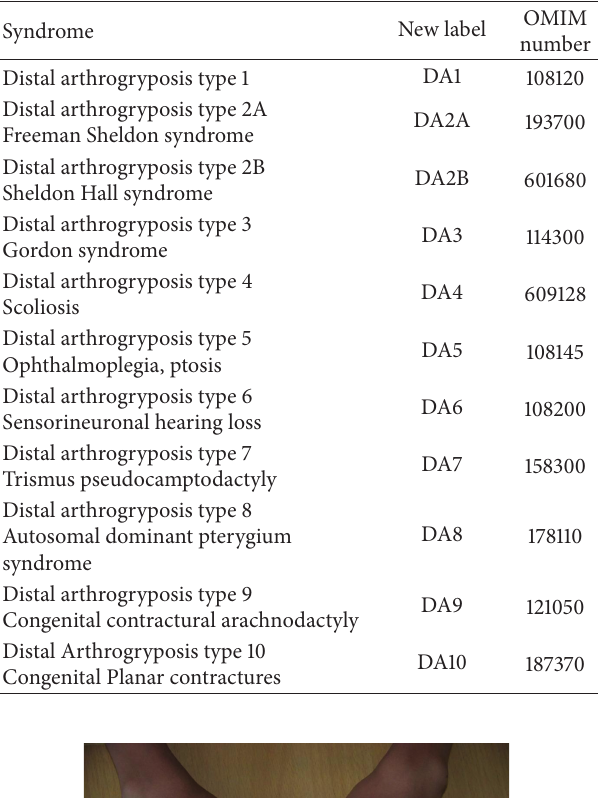
Table 1: Classification of distal arthrogryposes.